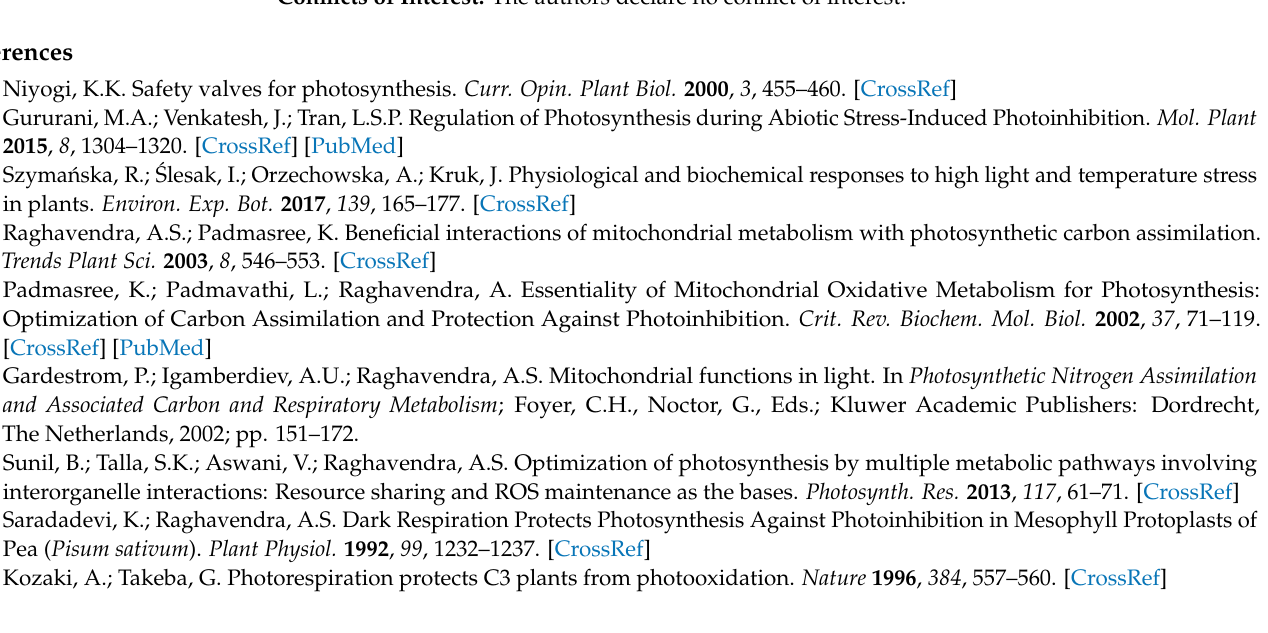
concentration of MD. Figure S2. The levels of ROS in pea leaf discs after treatment with MD (10 µ M) for varying periods. Table S1. Primers used in the